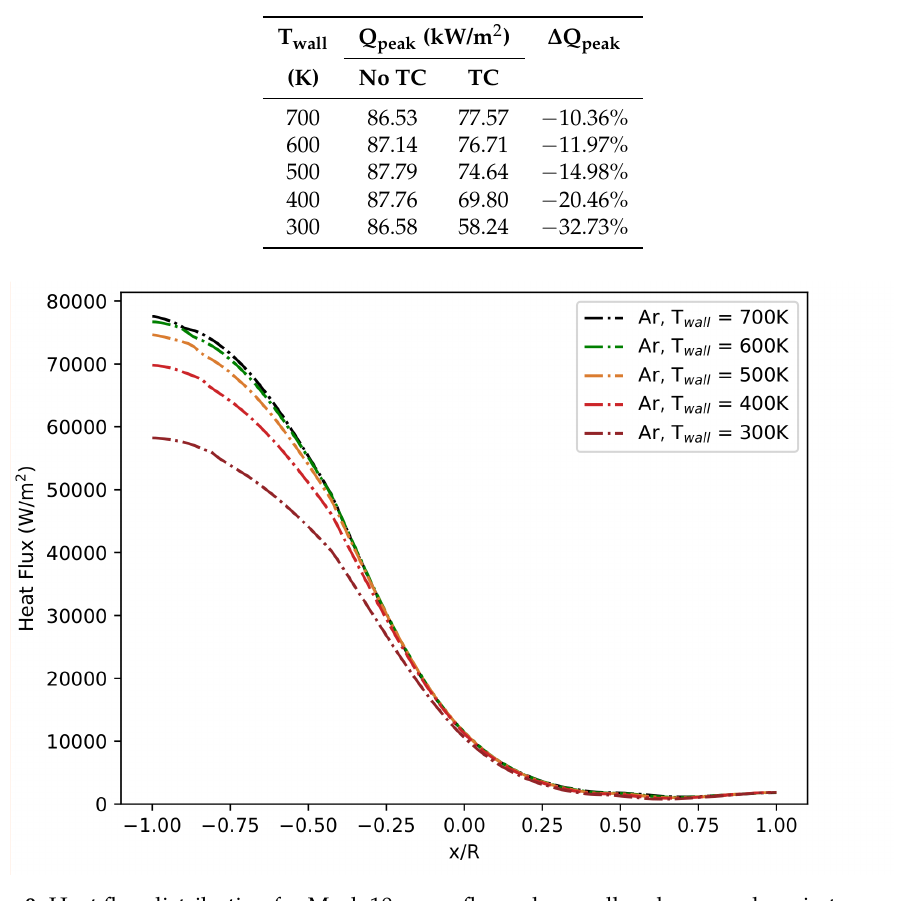
Table 6. Change in the incoming heat flux with changes in the wall and porous domain temperature (TC = transpiration cooling).